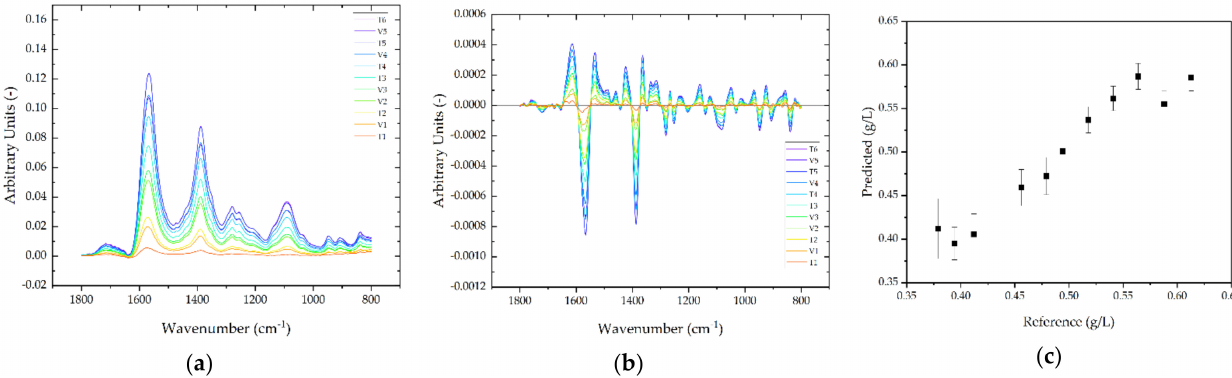
Figure 22. FTIR raw ( a ) and processed spectra ( b ) as well as titer prediction vs. reference ( c ) after alkaline lysis and clarification.